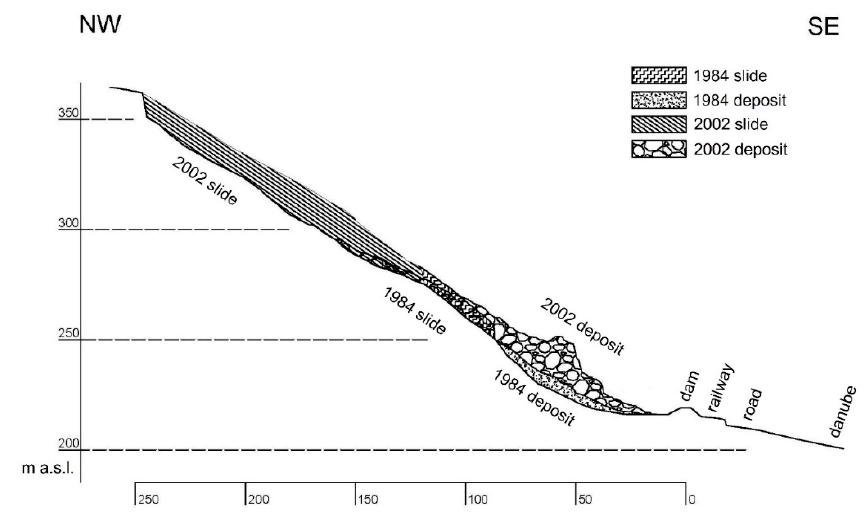
Figure 4. Detachments and deposits of rockslides on 4 October 1984 and on 11 October 2002.